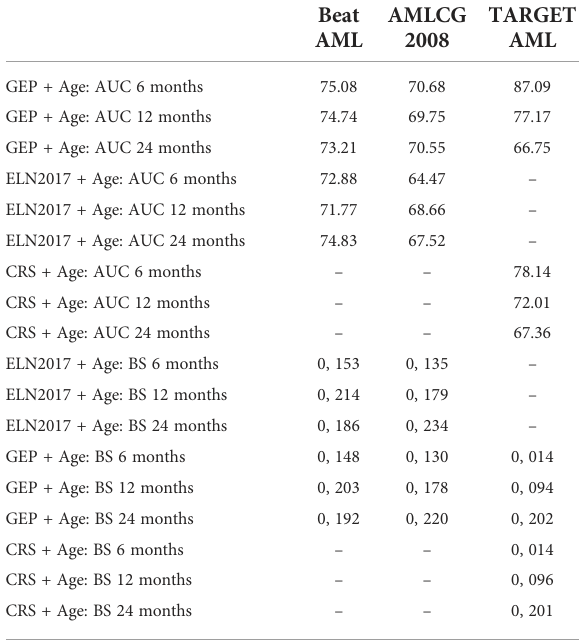
TABLE 4 Comparison in survival prediction between ELN-2017 classi fi cation and the pediatric Clinical Risk Score (CRS) with the Stellae-123 model over time including